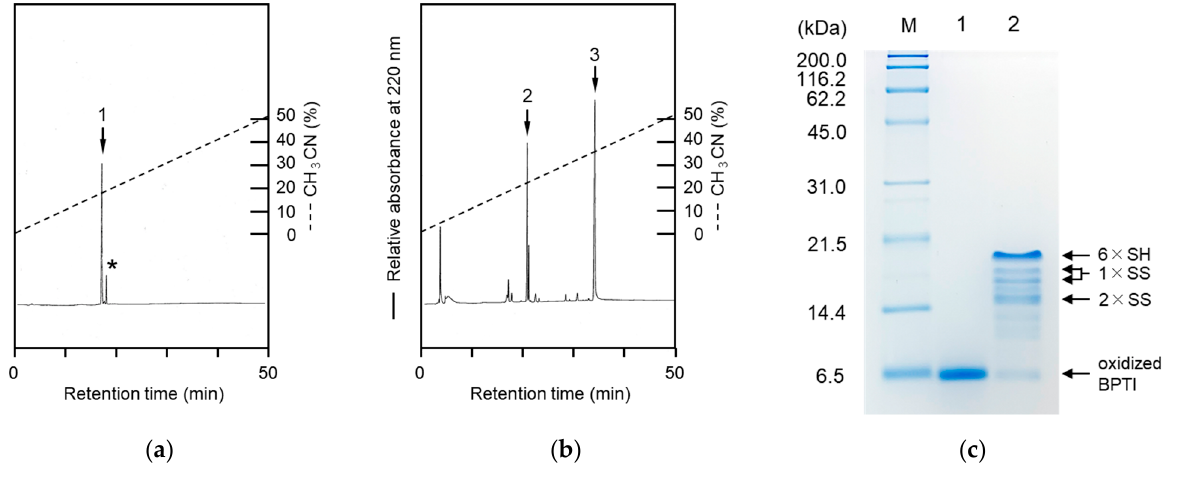
Figure 1. RP-HPLC profiles of the Arg 5 -Tyr-NH 2 peptide ( a ) and reaction mixtures ( b ) of the Arg 5 - Tyr-NH 2 peptide treated with N -succinimidyl 6-maleimidohexanoate. Tricine SDS-PAGE analyses ( c ) of the refolding solutions of BPTI. Peaks 1 and 2 were assigned to the Arg 5 -Tyr-NH 2 and the Male-Arg 5 -Tyr-NH 2 peptides, respectively, as evidenced by MALDI-TOF/MS. The asterisk and peak 3 represent an impurity and N -succinimidyl 6-maleimidohexanoate, respectively. Lanes 1 and 2 show the refolding solutions (1 h reaction) treated without or with the Male-Arg 5 -Tyr-NH 2 reagent. “M” represents marker proteins (Nacalai Tesque, Kyoto, Japan). RP-HPLC analyses were performed using a Hydrosphere C 18 column and the acetonitrile concentration was increased from 1% to 51% for 50 min.